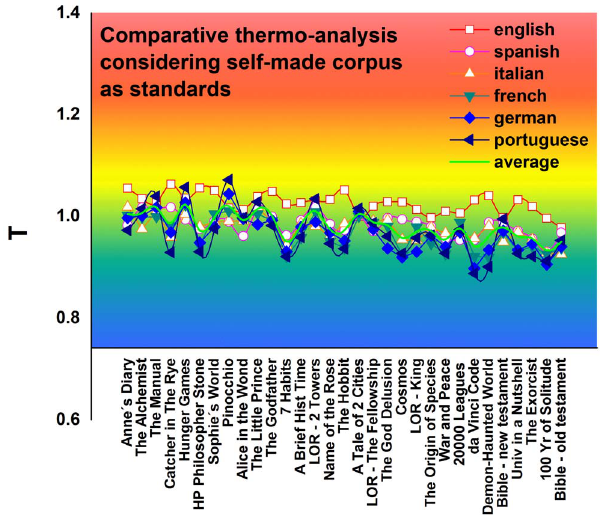
Figure 6. Temperature of books by using self-made corpus. Plots of the characteristic temperature for books considering a self- made corpus with all the books used for each language.